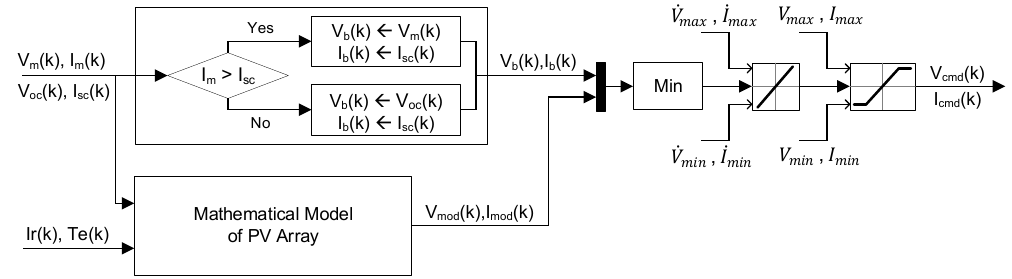
Figure 6. Proposed control algorithm with limitation values.